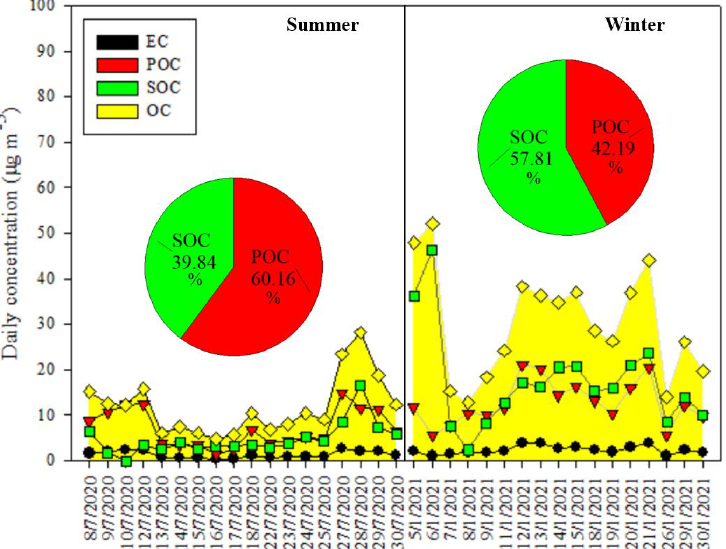
Figure 4. Daily variation of EC, OC, POC, and SOC concentration for the summer and winter periods.